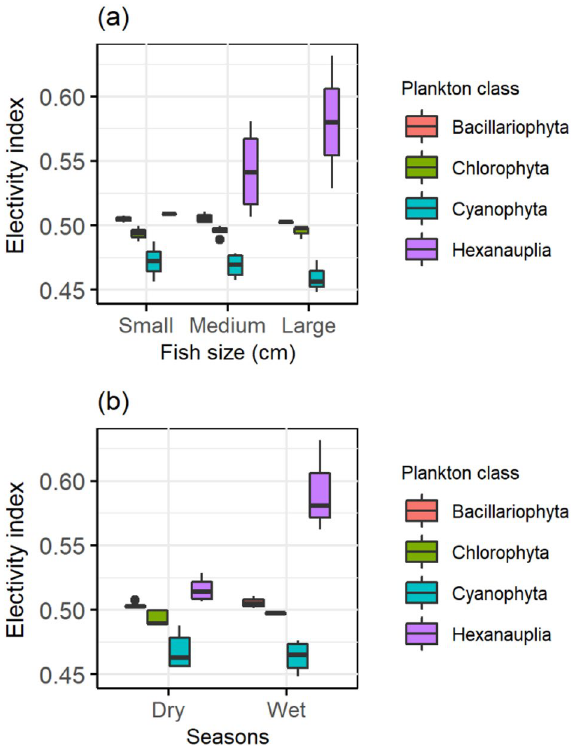
Figure 9. Electivity indices for ( a ) different size (small:10–20 cm, medium: 20–30 cm, large: 30–35 cm) of hilsa fish consuming ( b ) four abundant prey taxa (major group of phytoplankton) in the dry and wet